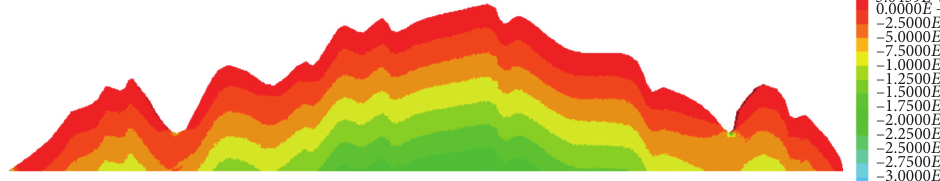
Figure 4: Stress inversion results.